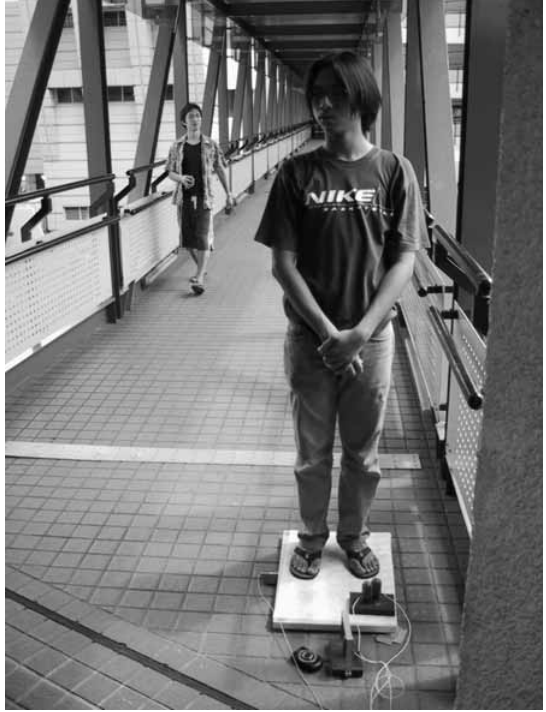
Fig. 10. Measurement of mitigating effect of stationary occupant on walking-induced response.